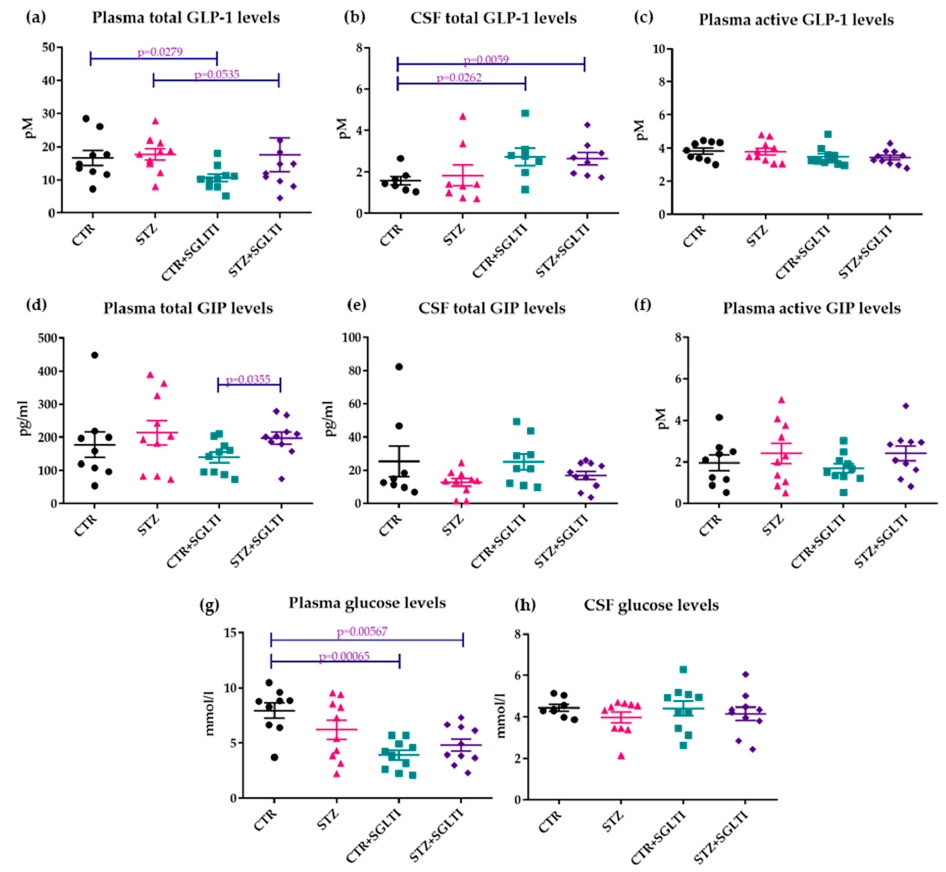
Figure 5. Biochemical analyses of plasma and cerebrospinal fluid (CSF) samples obtained at sac- rification following 2 months of phloridzin treatment. Results of ( a ) plasma total glucagon-like peptide-1 (GLP-1); ( b ) CSF total GLP-1; ( c ) plasma active GLP-1; ( d ) plasma total gastrointestinal inhibitory polypeptide (GIP); ( e ) CSF total GIP; ( f ) plasma active GIP; ( g ) plasma glucose; ( h ) CSF glucose. Data presented as mean ± SD with individual animal data and analysed by Kruskal–Wallis 1-way ANOVA with Wilcoxon signed rank tests for between-group comparisons. CTR—control group; STZ—streptozotocin-treated group; CTR+SGLTI—control group treated with phloridzin; STZ+SGLTI—streptozotocin-treated group treated with